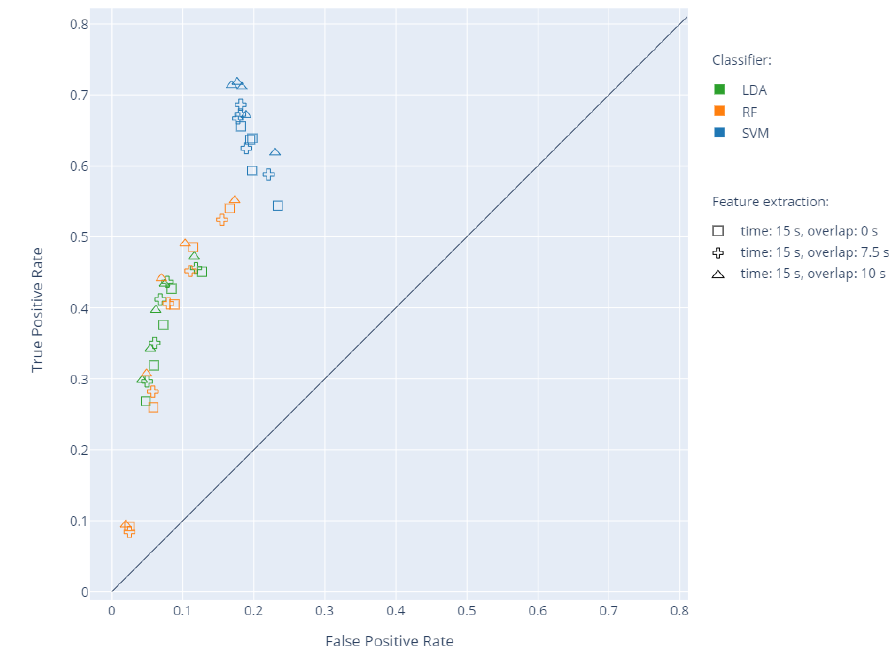
Figure 6. The individual results of cross-validation in the TPR to FPR space depending on the overlapping time for the analysis time of 15 s and the selection of a training set with different N values. The change in parameter N is represented by five identical markers for each pair of classifier and feature extraction